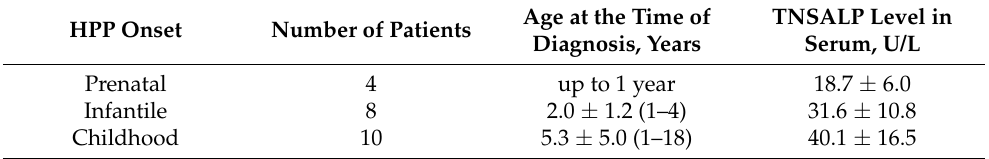
Table 1. Clinical forms of HPP in patients with two variants of the ALPL gene ( n = 22). HPP